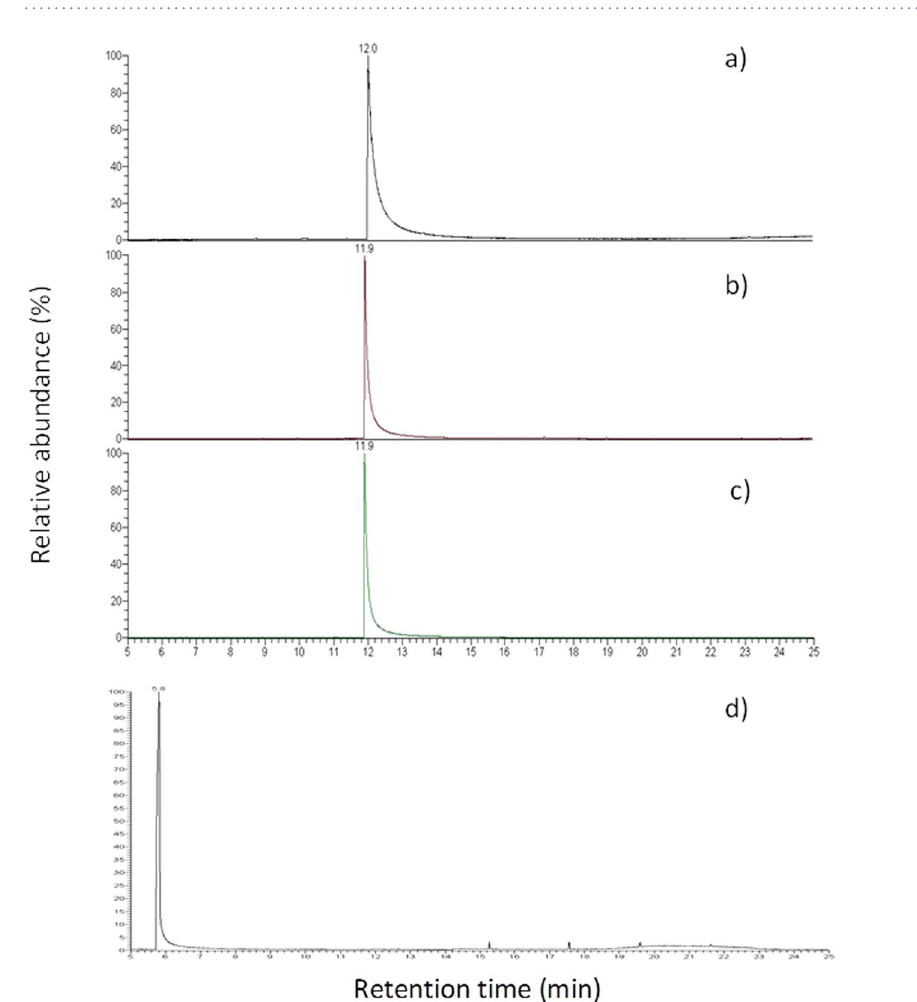
Table 1. DTA/TGA Analysis of compositions of PDO, PG, VG and